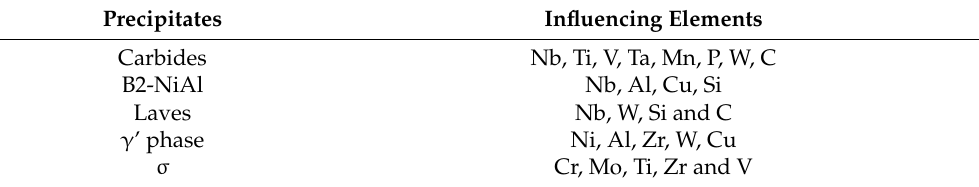
Table 2. The influencing elements to precipitates in AFA